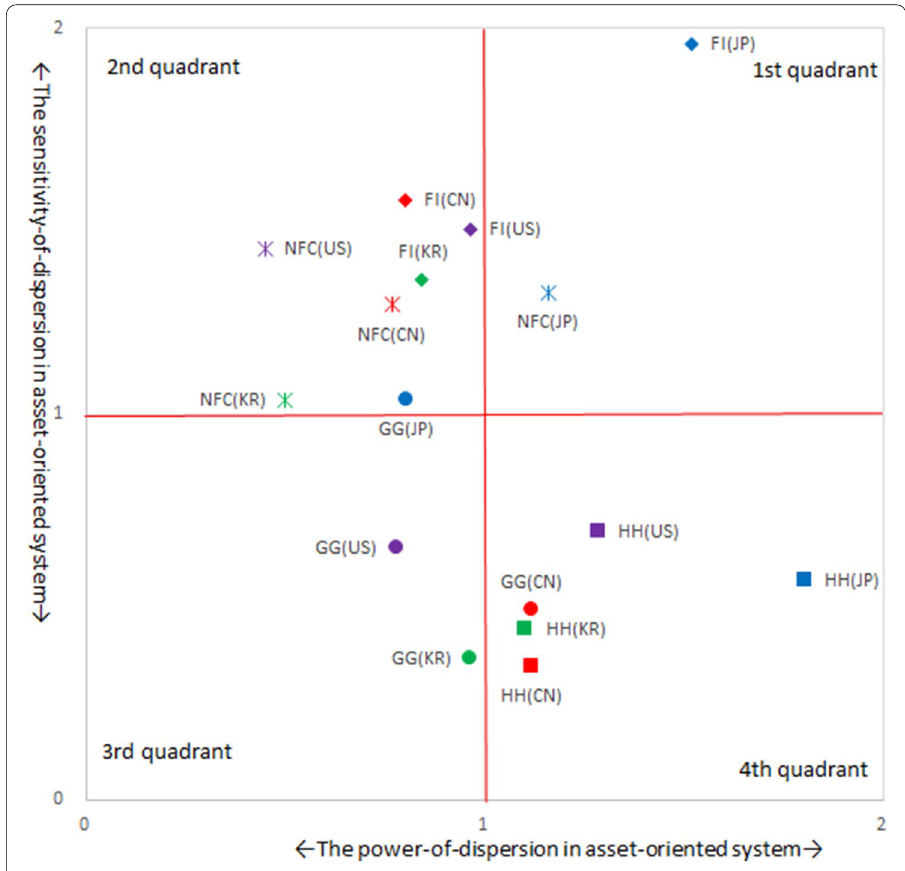
Fig. 7 Power and sensitivity indexes in the asset-oriented system,